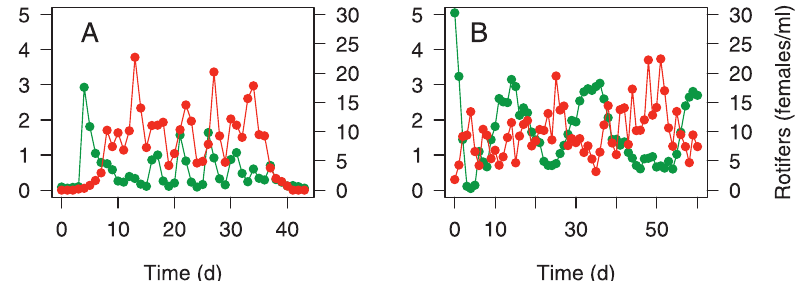
Figure 1. Experimentally Observed Cycles of Algae (Green) and Rotifer (Red) Populations in a Chemostat System (A) The entire initial algal population was descended from a single algal cell drawn from our stock cultures, and the predator was introduced quickly to limit algal population growth and reduce the opportunity for advantageous genotypes to arise by mutation. (B) An experiment in which the initial algal population was drawn from multiple sources and genetically variable. With prey genetic variation eliminated or greatly reduced (A), the system exhibited classical predator-prey cycles with increases in prey abundance followed by increases in predator abundance after a quarter-period lag. When the prey population is genetically heterogeneous and evolving (B), the cycles are longer and the oscillations in predator and prey abundance are almost exactly out of phase. The data are replotted from